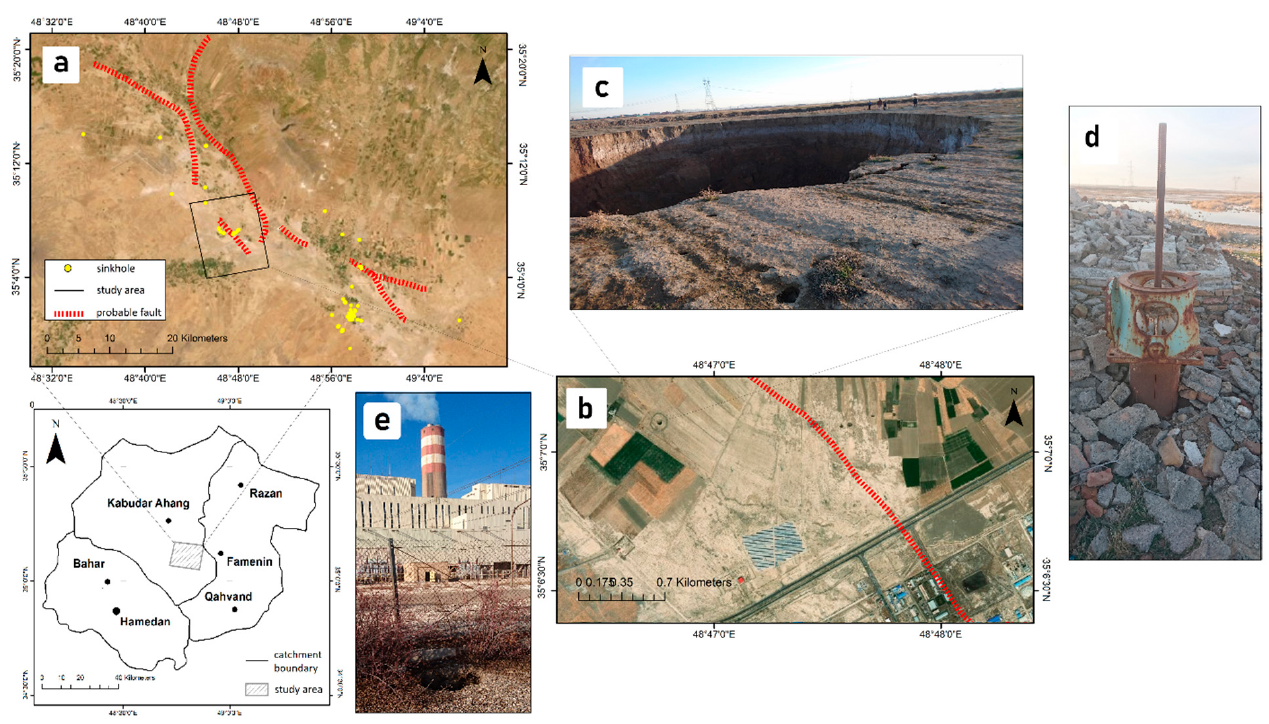
Figure 1. The study area. ( a ) The study area is marked with a black rectangle, faults with red lines, and sinkholes with yellow circles. ( b ) The region of the studied cave. ( c ) The sinkhole formed in August 2018. ( d ) A rod that indicates the existence of the long-term subsidence in the area. ( e ) Another hole near the Mofatteh power plant.